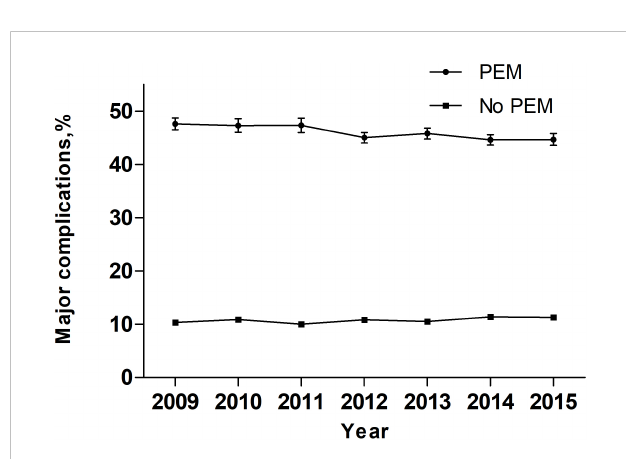
FIGURE 4 Major complications in patients with and without PEM between 2009 and 2015 in the United